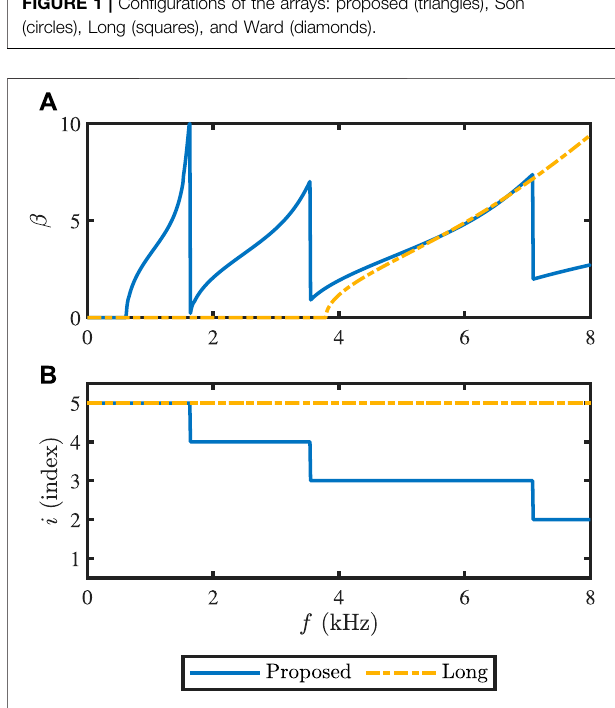
FIGURE 2 | Continuous Kaiser window parameters, (A) the window shape factor, and (B) the index ofthe window support from the set 2 x i { } 5 i (cid:2) 1 , as a function of frequency: proposed (solid line) and Long (dashed